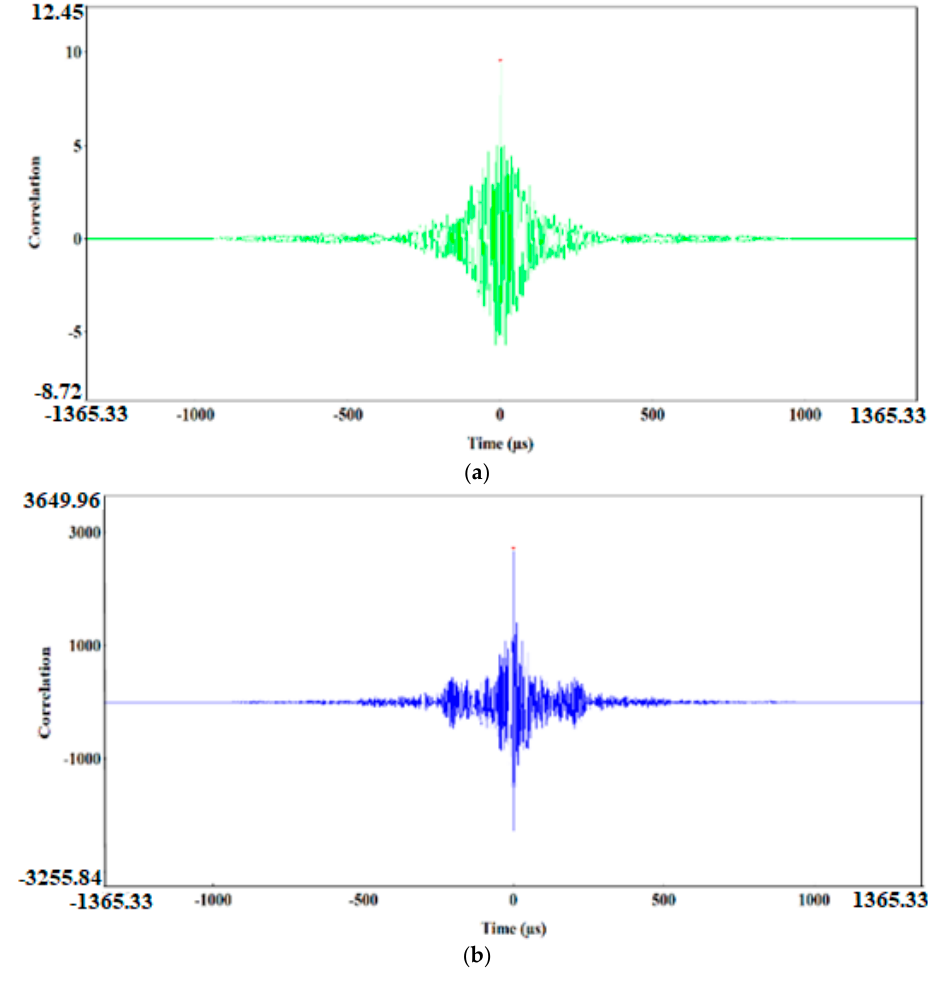
Figure 14. Waveform frequency domain (Real) ( a ) and waveform continuous wavelet (Morlet) ( b ) charts for the individual classes of AE signals (class 5).